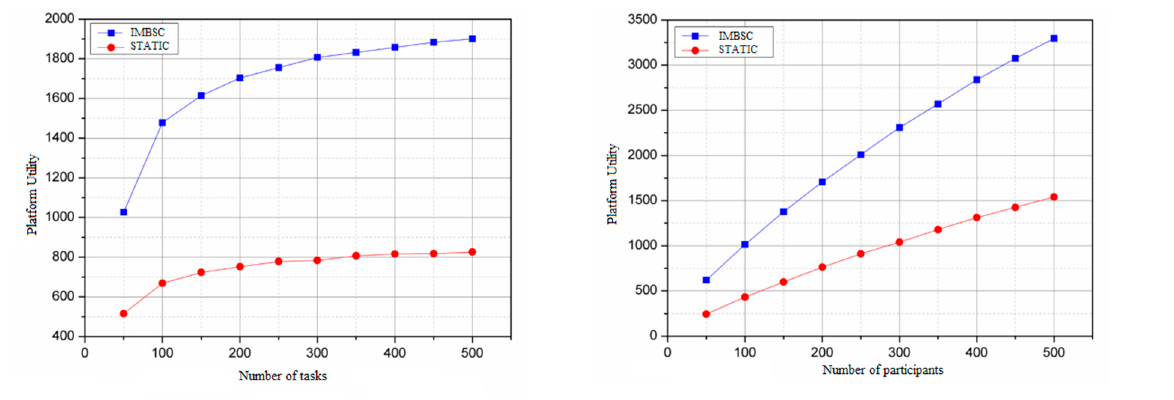
Figure 2. Platform utility depending on number of the tasks and participants.